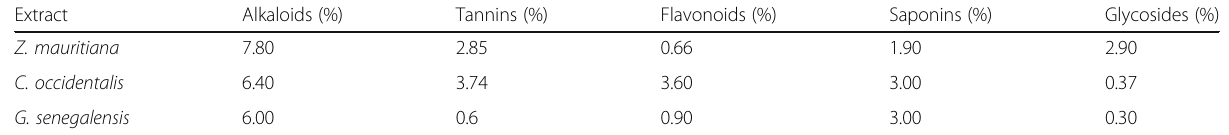
Table 2 Quantities of major phytochemicals detected in the methanol extracts of Z. mauritiana , C. occidentalis , and G . senegalensis